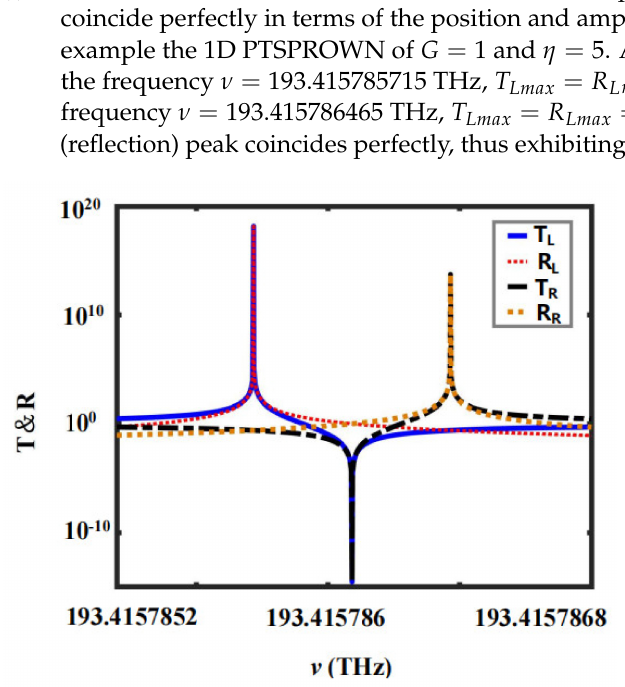
Figure 5. The transmission and reflection spectra of 1D PTSPROWN of G = 1 and η = 5, determined by the first extremum spontaneous PT-symmetric breaking point. The blue solid line and the red dotted line represent the left-incident transmission and left-incident reflection, respectively. The black point dotted line and the orange point line represent the right-incident transmission and right-incident reflection,